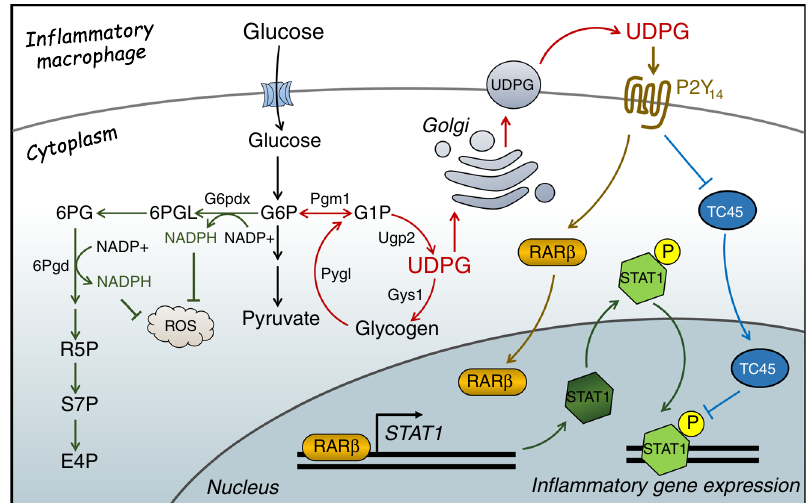
Fig. 9 Glycogen metabolism regulates macrophages. In in fl ammatory macrophages, glycogen is synthesized and then channeled through glycogenolysis to generate G6P and further through the pentose phosphate pathway to yield abundant NADPH, ensuring high levels of reduced glutathione for in fl ammatory macrophage survival. Glycogen metabolism also increases UDPG levels and the receptor P2Y 14 in macrophages. The UDPG/P2Y 14 signaling pathway not only upregulates the expression of STAT1 via activating RAR β but also promotes STAT1 phosphorylation by downregulating phosphatase